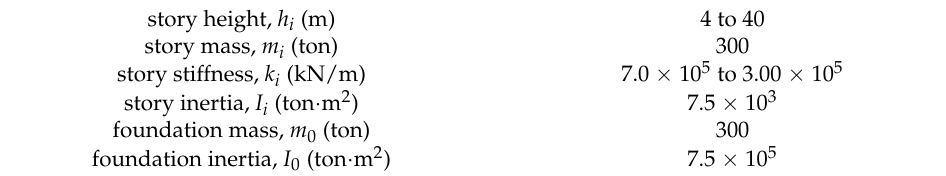
Table 6. Properties of the ten-story